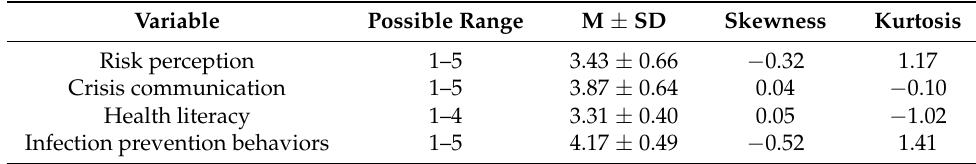
Table 2. Descriptive statistics of COVID-19-releated variables (N = 157).